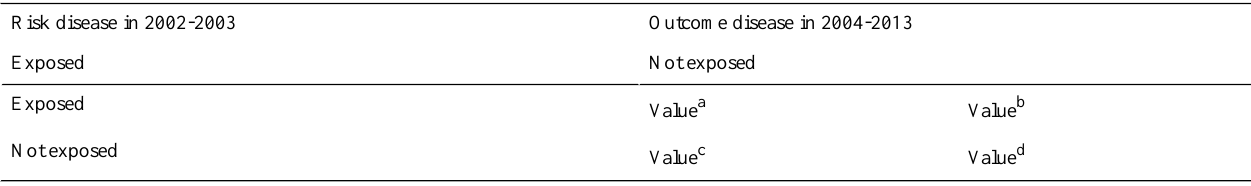
Table 1. Contingency table for disease-disease risk ratio